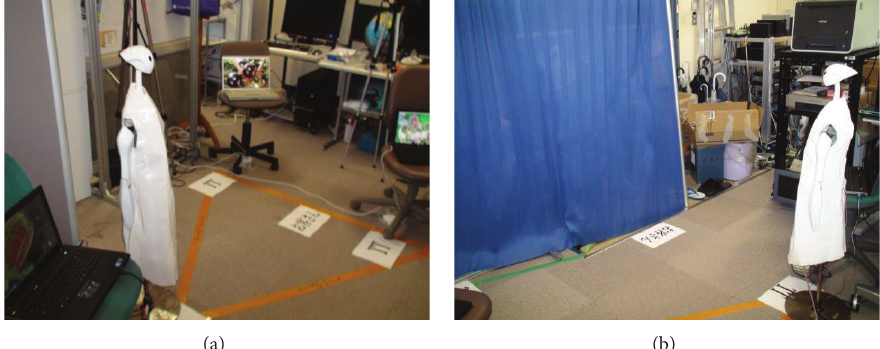
Figure 3: (a) Robot placed beside the first exhibit. (b) The robot placed on its label-marked position, waiting for the subject to step in front of